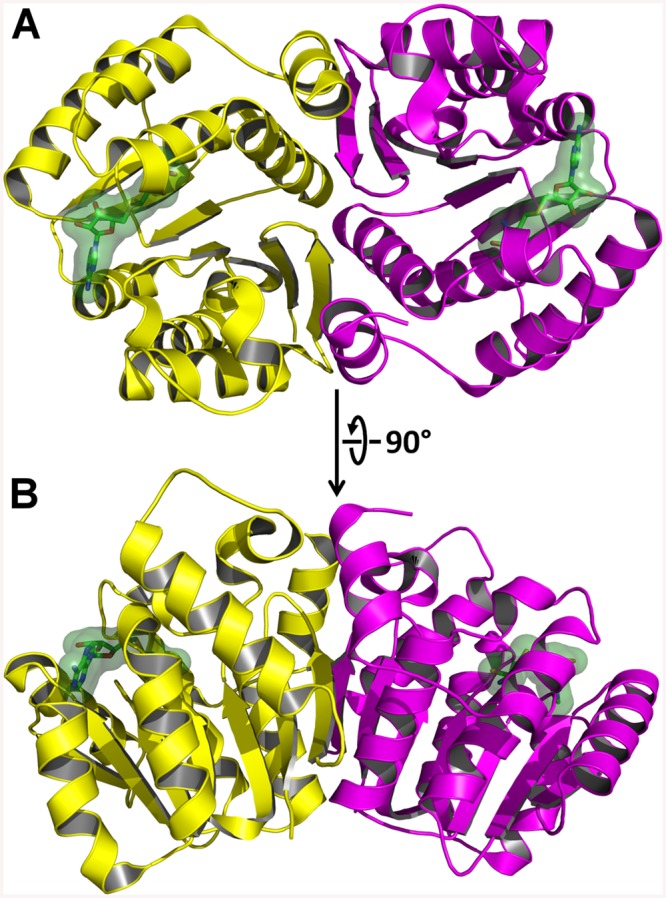
X-Ray Crystal Structure of AnphA.01233.a Bound to SAH.The crystal structure of A. phagocytophilum OMT was produced in association with SAH molecules or without (Apo). A) Ribbon representation of the AnphA.01233.a dimer crystal structure. Molecules A and F from the PDB 4OA5 are colored yellow and magenta, respectively. The bound SAH molecule is represented in stick format surrounded by a transparent green surface. B) View of the AnphA.01233.a dimer rotated about the X-axis by 90 degrees as compared to A.